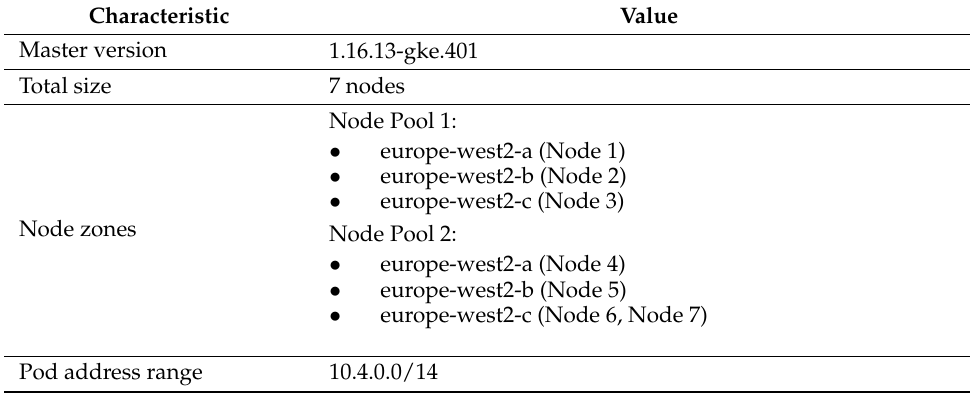
Table A2. e-health-system–K8s cluster.